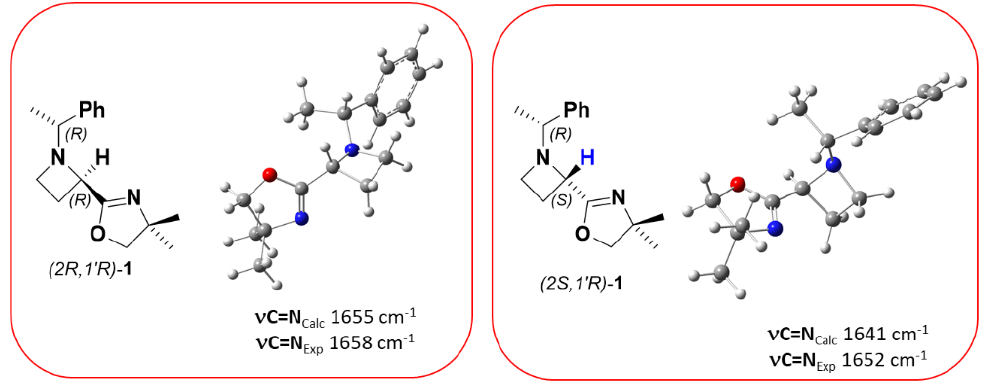
Figure 3. Computed unscaled wavenumber (cm −1 ) for C=N bond of the optimized neutral structures of diastereomers anti -(2 R , 1′ R )- 1 and anti -(2 S , 1′ R )- 1 in the solvent phase using THF and by applying IEF-PCM solvation model at the BVP86/6-31+G(d,p).